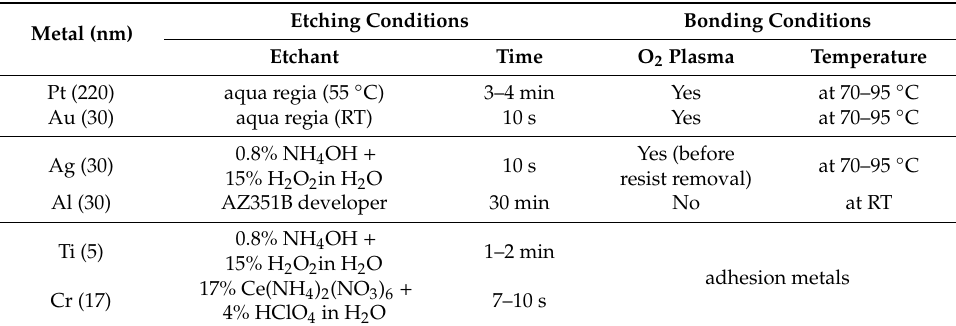
Table 2. The optimized metallization and bonding